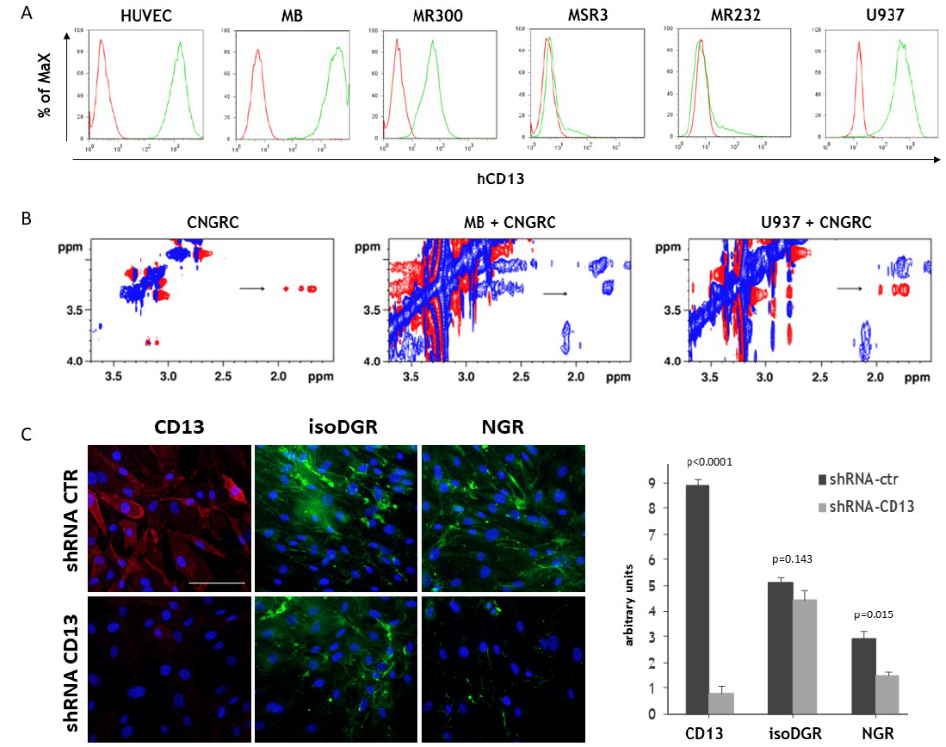
Figure 2. CD13 expression and NGR-binding properties in di ff erent cell lines. ( A ) Flow cytometry analysis of CD13 expression (green histograms) in the indicated cell lines. Red histograms represent isotype control. ( B ) Representative 2D TR-NOESY spectra are shown. Left spectrum (tmix = 600 ms): free CNGRC with positive NOEs (red peaks). Middle spectrum (tmix = 100 ms): CNGRC, in the presence of MB cells, transiently adopts, during binding to the CD13, the tumbling time of the receptor and transfer the negative NOE of the protein complex to the population of the free molecule (blue peaks). At longer mixing time (600 ms) the signal has decayed (Supplementary Figure S1B). Right spectrum (tmix = 600 ms): CNGRC, in the presence of U937 cells, does not bind to the receptor, thus its NOE cross peaks are positive (red peaks). The arrows indicate the cross-peaks deriving from correlations of the arginine δ / γ and δ / β protons of the CNGRC peptide. ( C ) Binding of NGR-biotin (green) to target cells (MB) is prevented by CD13 silencing with shRNA, whereas isoDGR-biotin (green), an unrelated integrin-specific peptide, does not. The down modulation of the CD13 receptor is confirmed by staining with the anti-CD13 Ab (red). On the left panel, a representative experiment is shown (Scale Bar, 50 µ m). On the right panel, the quantification of the binding is reported (media and SE of three independent experiments).